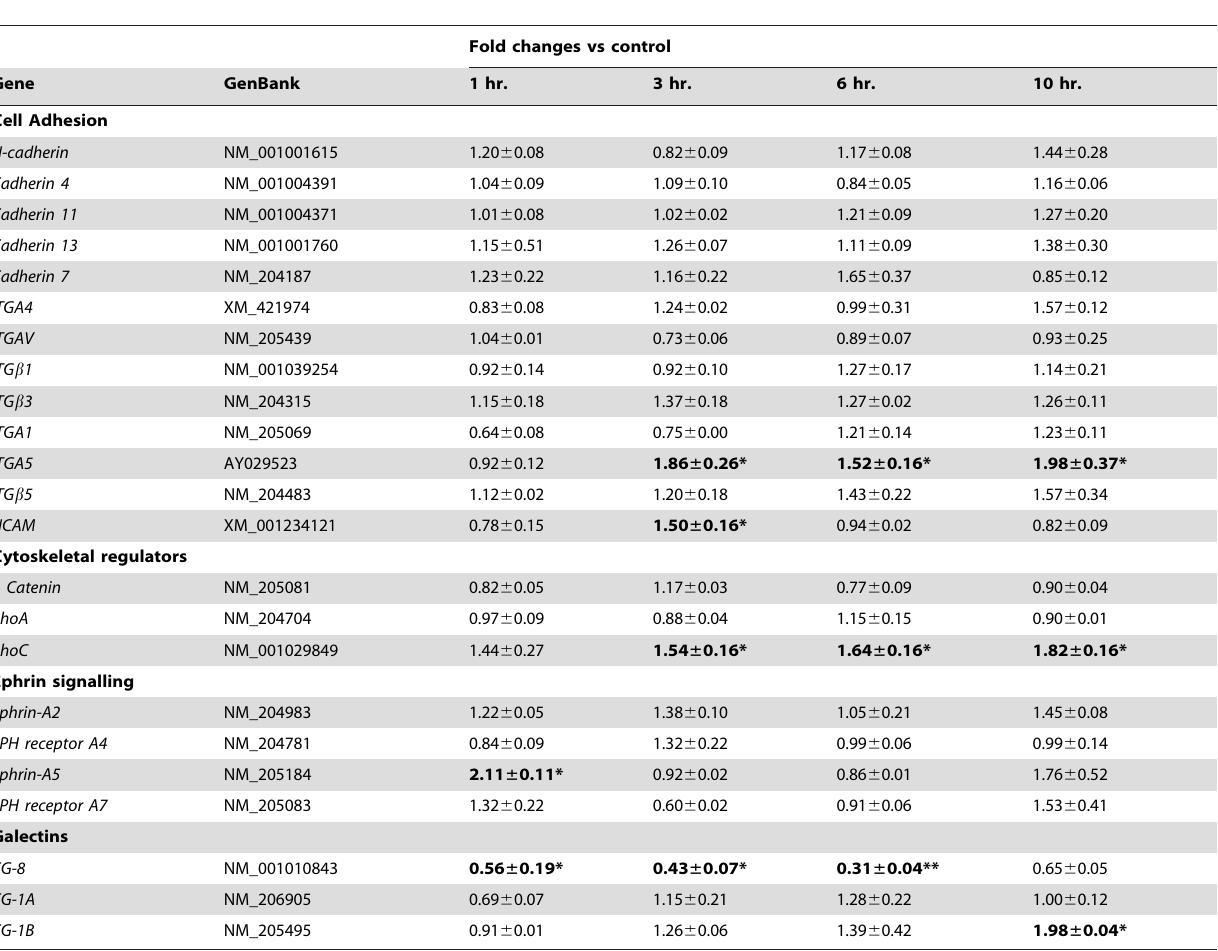
Table 1. Regulation of genes involved in the control of cell adhesion at 1, 3, 6, and 10 hr after interdigital implantation of beads bearing Tgf- b